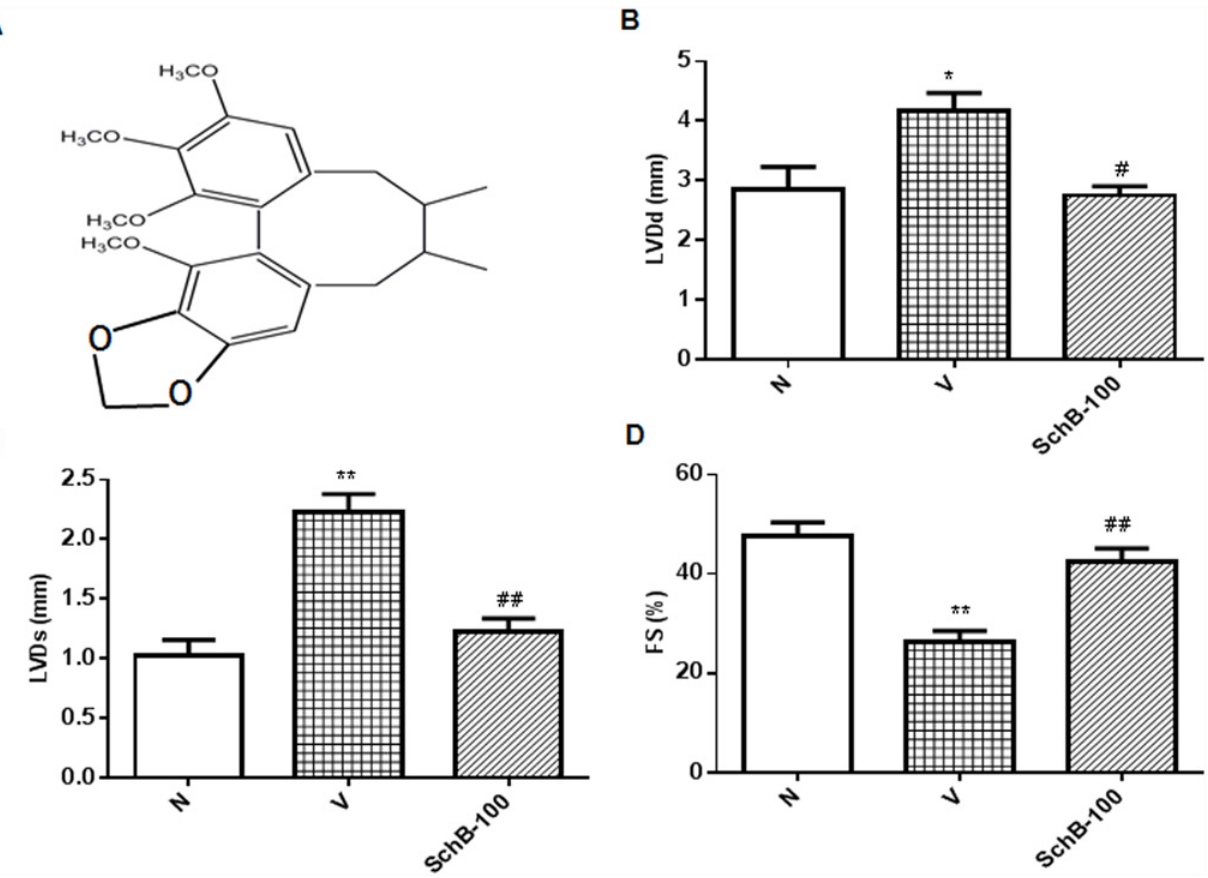
Fig 1. Sch B suppressed doxorubicin-induced cardiac functional loss. (A) Chemical structure of Sch B. (B – D) Mice were treated with a single dose of doxorubicin (20 mg/kg, i.p.) with or without pretreatment of Sch B, followed by analysis of cardiac function of the left ventricle by echocardiography as described in Materials and Methods. Each bar represents means ± S.E. (n = 3 – 5). ** P < 0.01 vs. group N mice; # P < 0.05 and ## P < 0.01 vs. group V